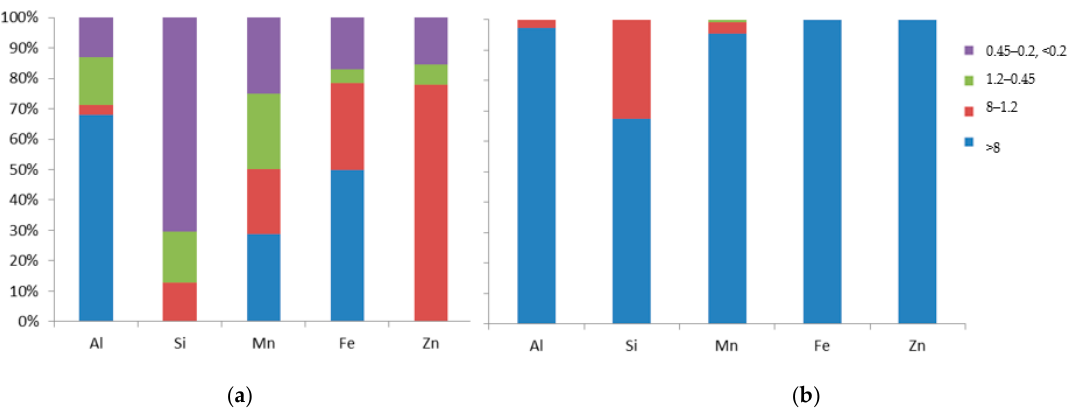
Figure 6. The percentage of different metals specification (size - μ m). ( a ) Sample 2 (forest); ( b ) Sample 6 (city, near State hydrological institute).